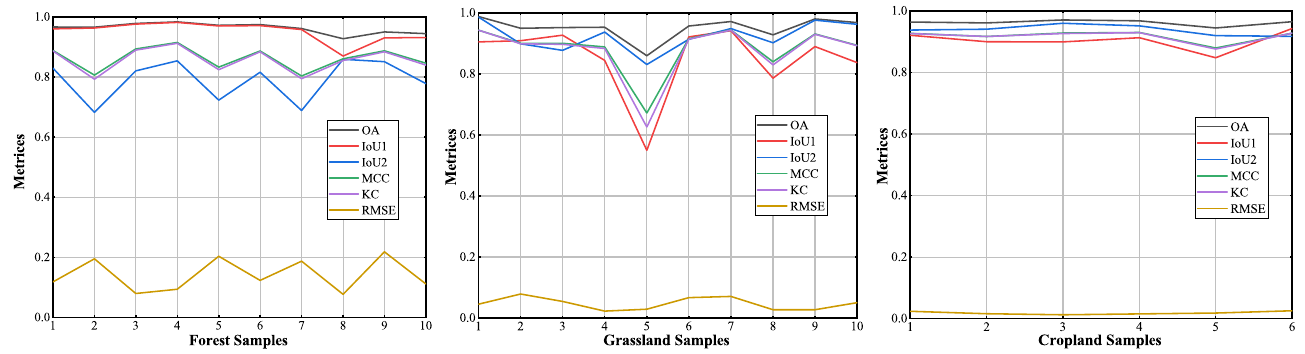
Figure 11. Per-sample performances in different land use